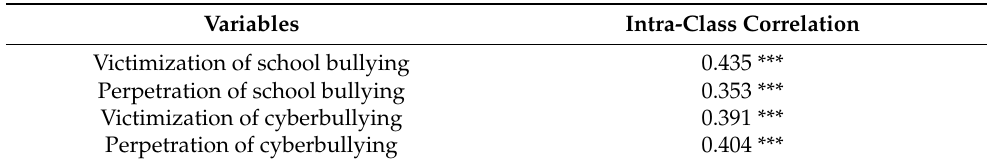
Table 2. Levels of adolescent–caregiver agreement regarding the bullying involvement experiences of adolescents with autism spectrum disorder ( N = 219).